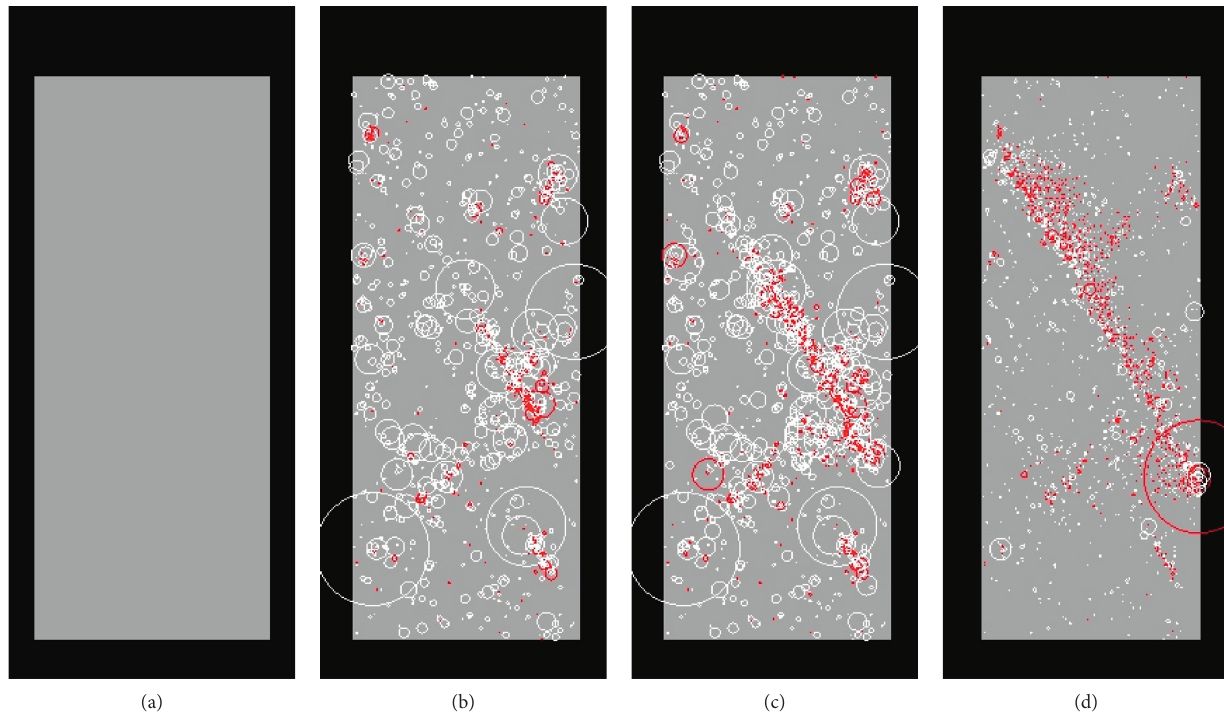
Figure 14: Acoustic emission propagation process of rock mass at ratio of height to diameter of